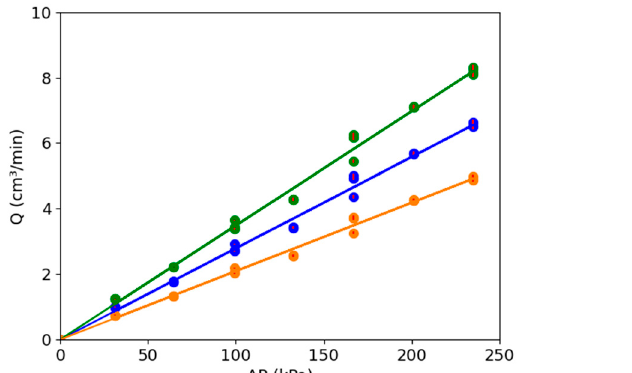
powder tablets (obtained at 60 MPa, 80 MPa, 100 MPa, 120 MPa, 140 MPa, 160 MPa, 160 MPa, 180 MPa, and 200 MPa), were used to estimate the permeability. 180 MPa, and 200 MPa), were used to estimate the permeability.